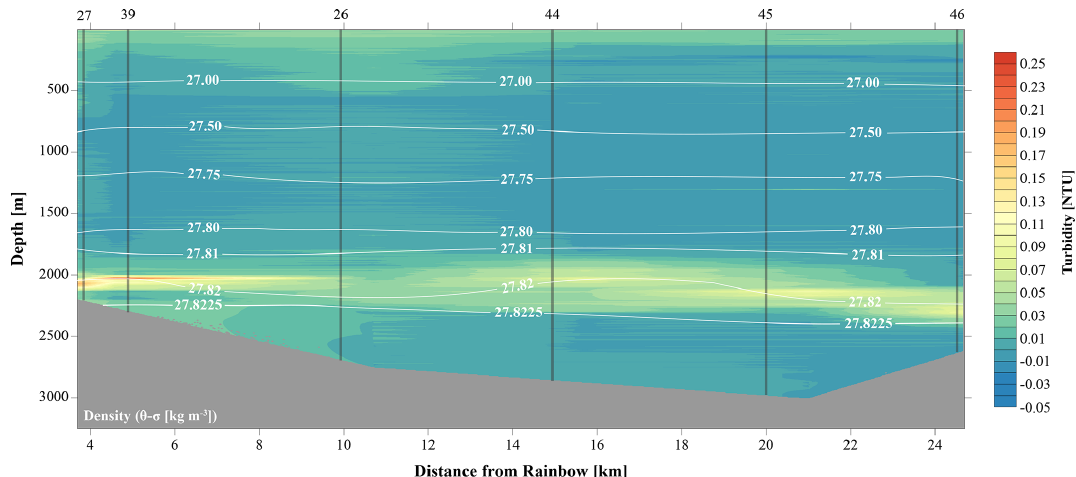
Figure 2. Transect along main plume path (indicated in Fig. 1 as plume transect), showing turbidity in the water column. The plume is indicated by highest turbidity values and disperses away from the Rainbow vent field.